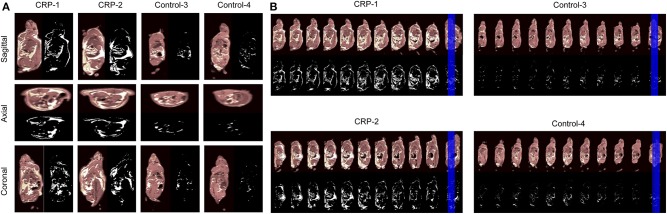
Body fat distribution accessed by MRI. In order to examine whether the higher body weight of CRP transgenic rats is due to increased fat volume, we measured the body fat distribution by MRI. Male 26-week-old rats of human CRP transgenic line 519 (n = 1), line 488 (n = 1) and their non-transgenic littermates (n = 2) were included in this experiment. (A) The views at the sagittal slices, the axial slices and the coronal slices. The fat volume is quantitated with the Image J software. The total fat volume of transgenic rats was 6-9 fold higher than control rats (Sagittal, 6.0-fold; Axial, 6.7-fold; Coronal, 8.9-fold). Among the fat mass, 11.8% was subcutaneous fat, and 88.2% was intra-abdominal fat in transgenic rats. About 63.0% of body fat was the omental fat; (B) Continuous sagittal sections scanned from nose-to-tail throughout the body. In these continuous sections, all of them are across the renal hilum. The pictures are shown in gray-scale and black-white, in which white areas indicate the fat. These MRI data confirmed that the CRP transgenic rats developed visceral obesity with accumulated intra-abdominal visceral fat.